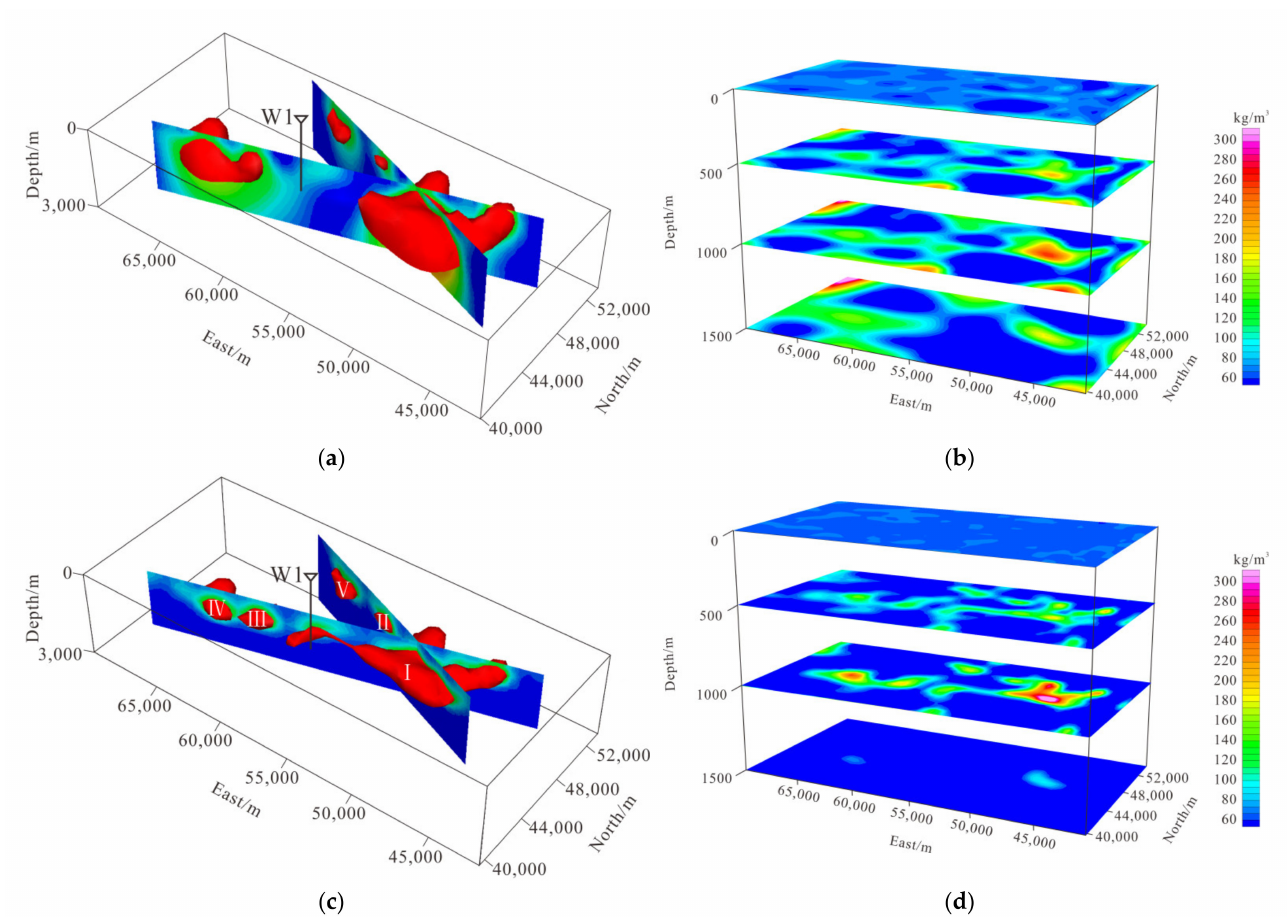
Figure 13. Density inversion result of real data. ( a ) The vertical slices and the 3D density results with the value larger than 0.2 kg/m 3 computed by data combined joint inversion method. ( b ) The horizontal slices of 3D density results computed by the data combined joint inversion method. ( c ) The vertical slices and the 3D density results with a value larger than 0.2 kg/m 3 computed by the proposed cooperative density inversion method. ( d ) The horizontal slices of 3D density results computed by the proposed cooperative density inversion